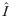
Task performance under uncertainty differs between neurotypical and restricted local
inhibition models.(A) A module was added (forest green) that modulates the intermediate layer E/I tone according to the uncertainty level. The E/I tone were determined using continuous functions, similar to those shown in Figs 4C and 6B. In the restricted inhibitory tone model, inhibition was limited to −0.01. (B) A single session of the simulation, where the X-axis is trial number, and Y-axis is the proportion of trials where the models choose the larger option. (C) Performance between the models diverges as uncertainty increases. The proportion of the trials where the larger alternative was chose is given as a function of uncertainty for both models. (D) The optimal indifference curvature differs between models as uncertainty increases. To the right are example indifference curves for neurotypical (top) and restricted local inhibition (bottom) models at their maximum level of concavity. Input values (I^) are normalized by the reference choice alternative values’ linear sum.